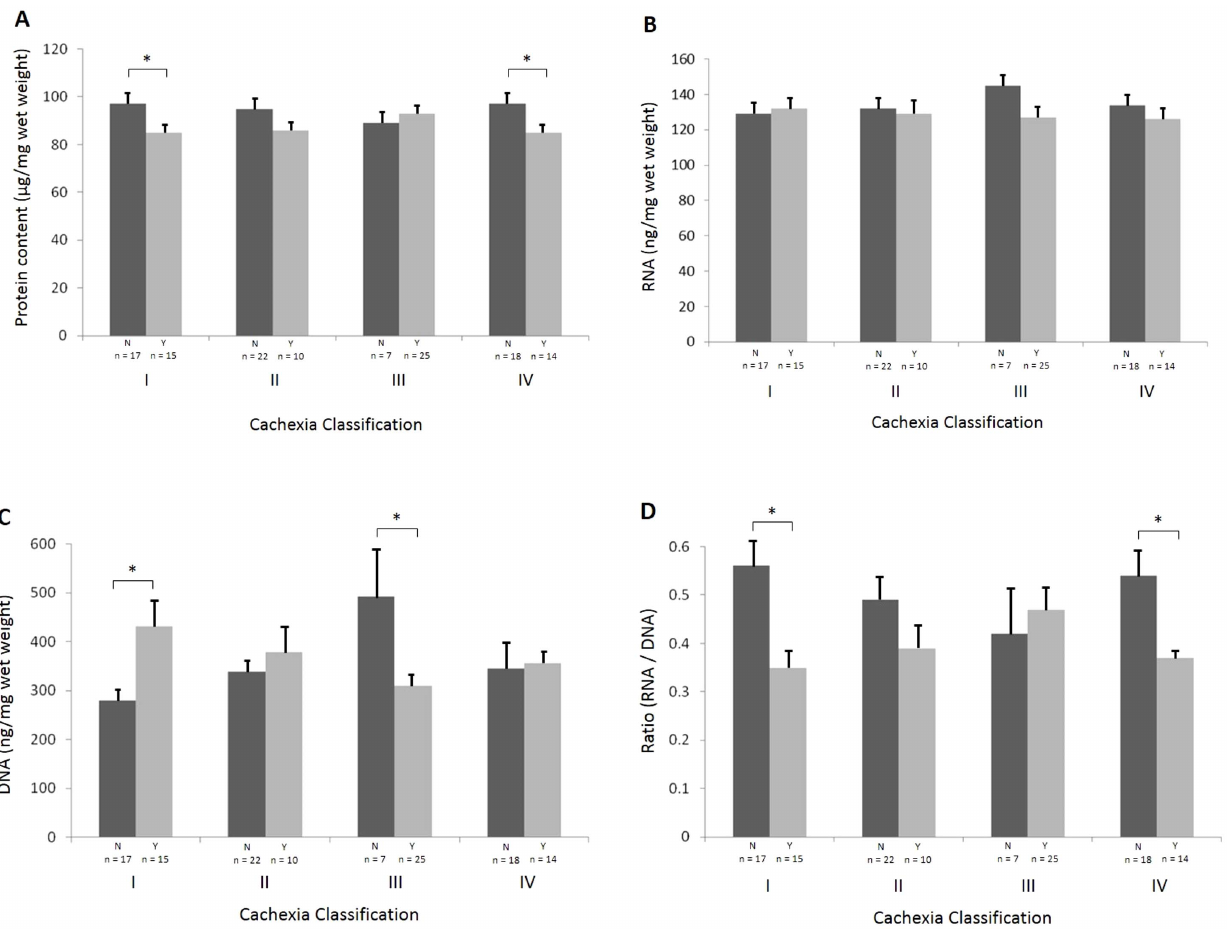
Figure 2. Variations in protein and nucleic acid content according to the different definitions of cancer cachexia. A comparison is made between patients with the proposed cachexia definition absent (dark grey) and those with the proposed cachexia definition present (light grey) for the four definitions set out in the methods (I–IV). (A) Mean ( 6 SEM) wet weight protein content. (B) Mean ( 6 SEM) RNA content. (C) Mean ( 6 SEM) DNA content. (C) Mean ( 6 SEM) RNA/DNA ratio. (*, P , 0.05 by Student’s t